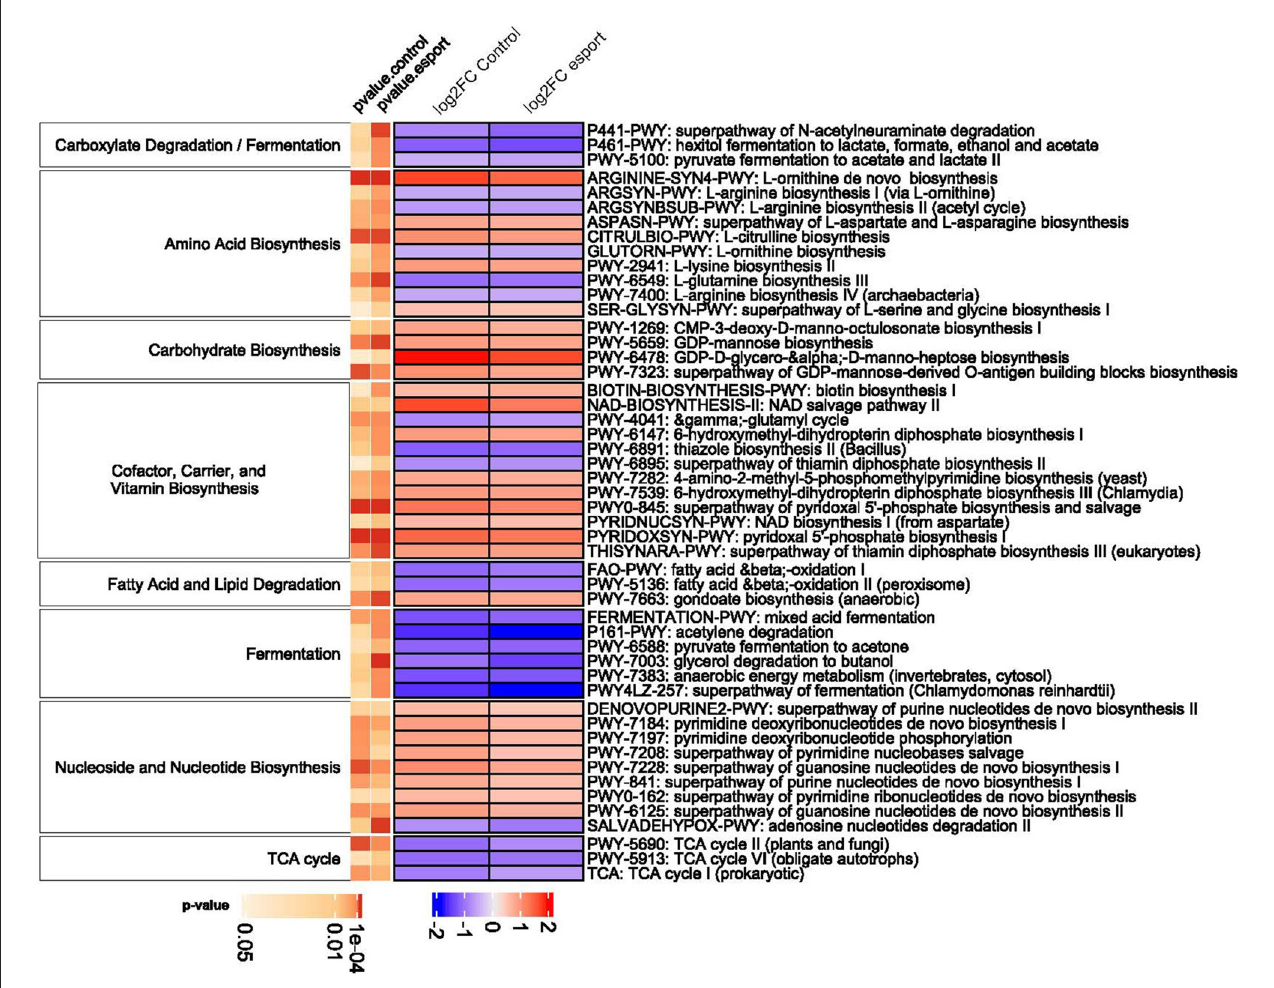
FIGURE9 Pathways differentiating between the three groups (grouped by their super pathways). The heatmap demonstrates log2-transformed data. Only categories with at least three pathways are shown.